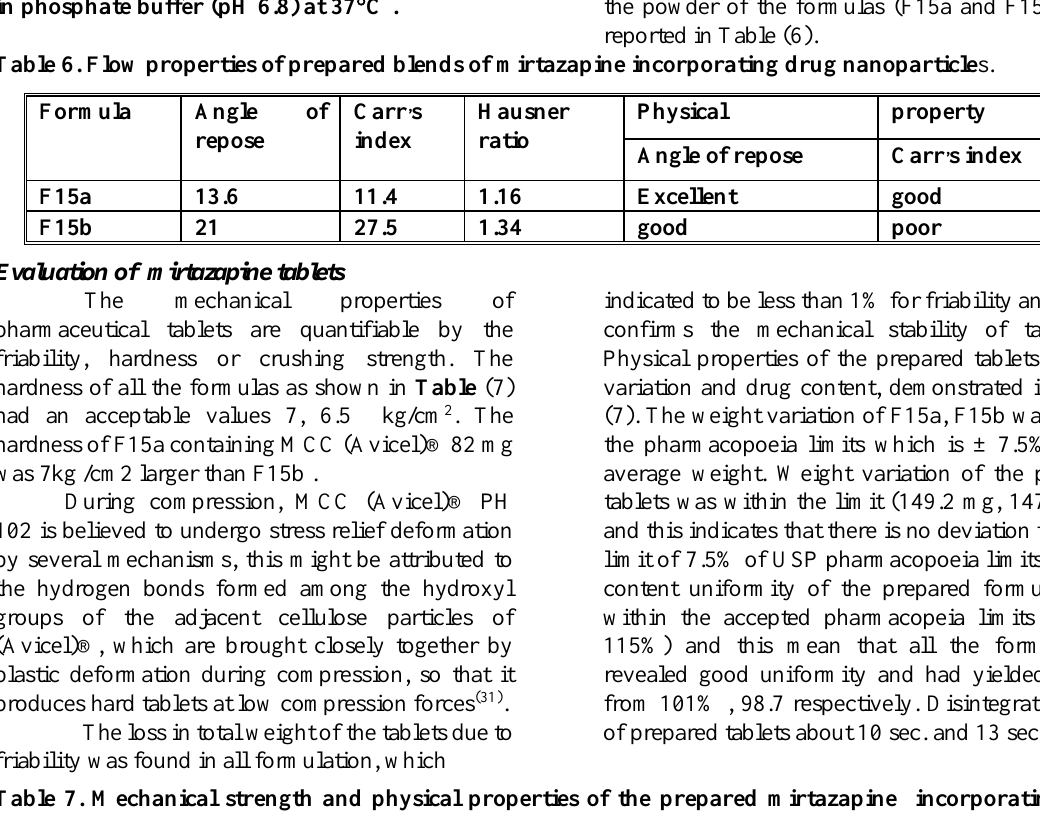
Table 7. Mechanical strength and physical properties of the prepared mirtazapine incorporating drug nanoparticles